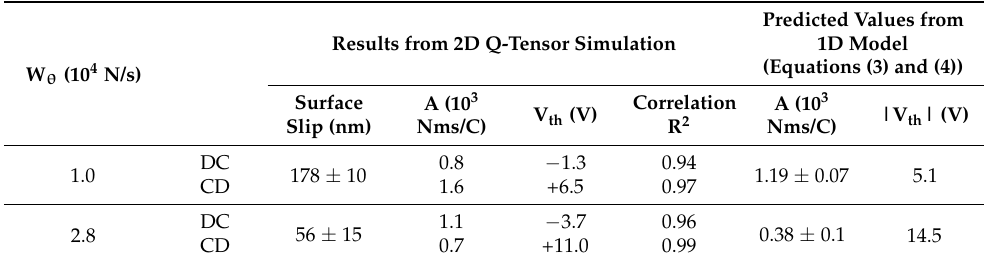
Table 3. Summary of the fits of the 2D Q-tensor simulation to Equation (5), compared with the anticipated values for weak and strong anchoring